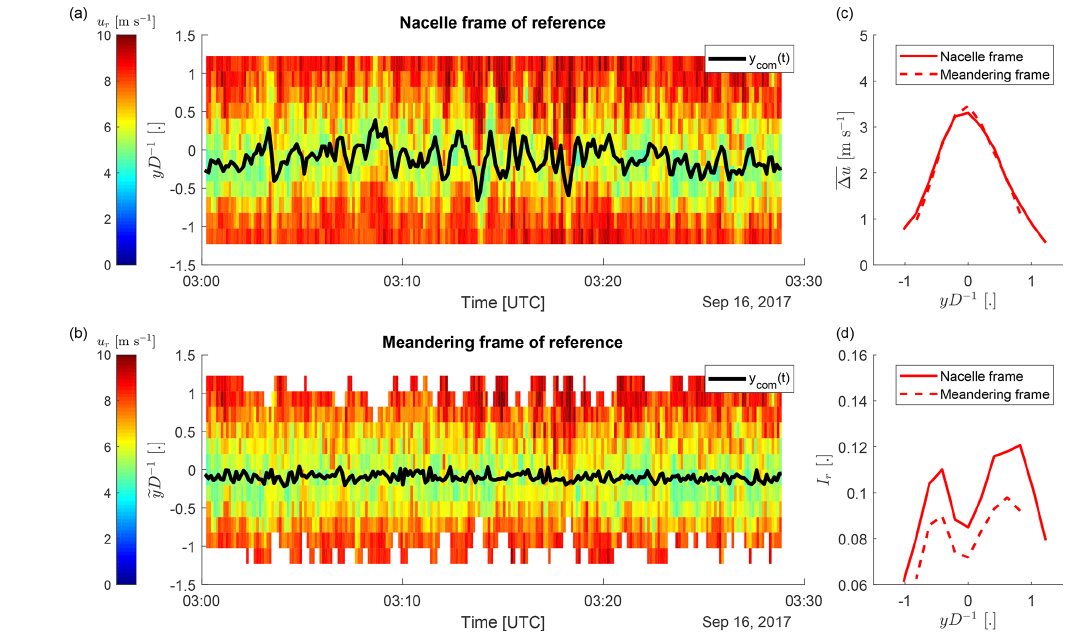
Figure 11. Time series of radial velocity profiles at xD − 1 = 6 in the nacelle frame of reference (a) and the meandering frame of reference (b) . The corresponding mean longitudinal velocity deficit profiles are shown in (c) and the radial turbulence intensity profiles in (d)